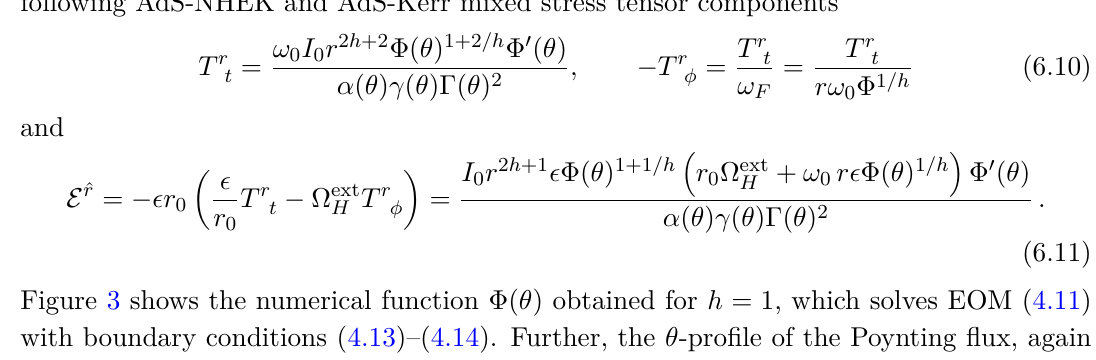
JHEP12(2020)018 = 0 . 5 , = 1 H 2 M